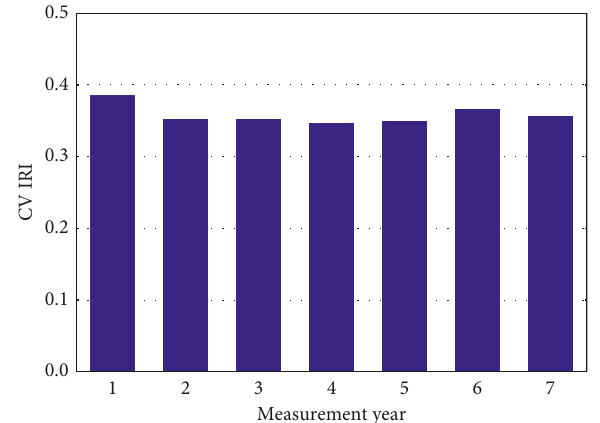
Figure 5: Variability of IRI values.